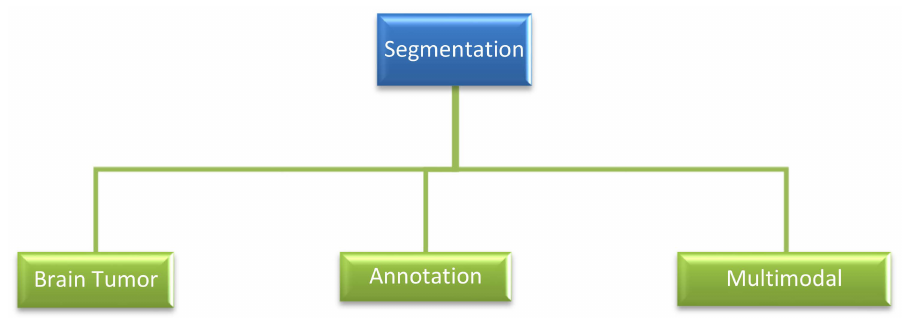
Figure 6. Grouping of segmentation